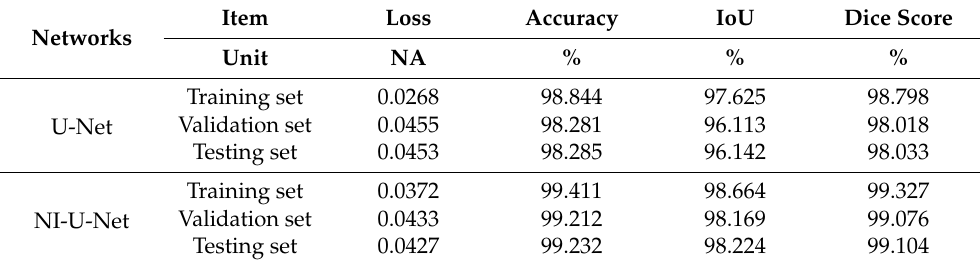
Figure 8. The loss (binary cross-entropy), accuracy, IoU, and Dice score records of the pre-training process in training and validation set (the Skyfinder dataset). ( a – d ) refer to the loss (binary cross-entropy), accuracy, IoU, and Dice score, respectively. Table 1. The loss, accuracy, RMSE, and IoU results of the pre-trained sky and ground segmentation network.